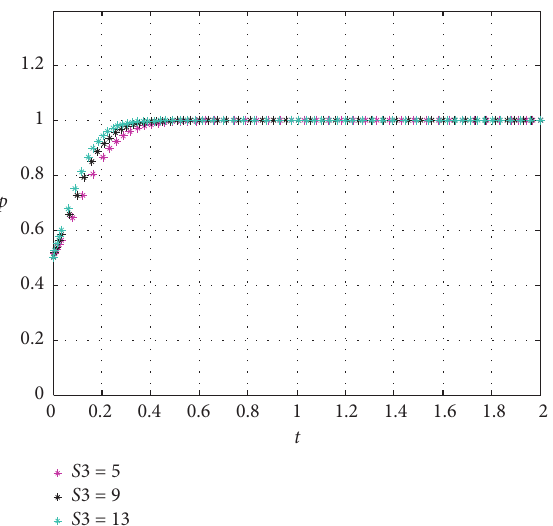
Figure 13: Evolutionary trajectory of banks’ behavior under . different S 3